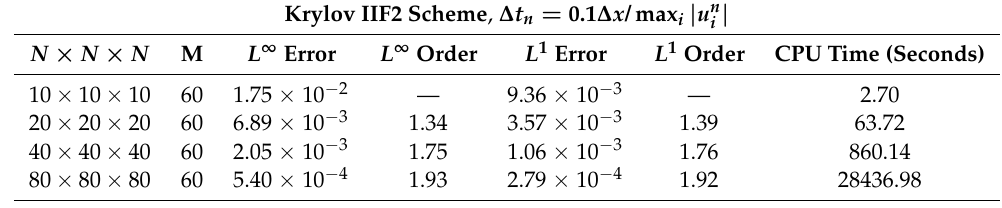
Table 6. Example 6. Fourth-order equation with nonlinear advection and reaction terms in three dimensions. CPU time, numerical errors and orders of accuracy of Krylov IIF2 and Krylov IIF3 schemes. M is the Krylov subspace dimension. Final time: T =